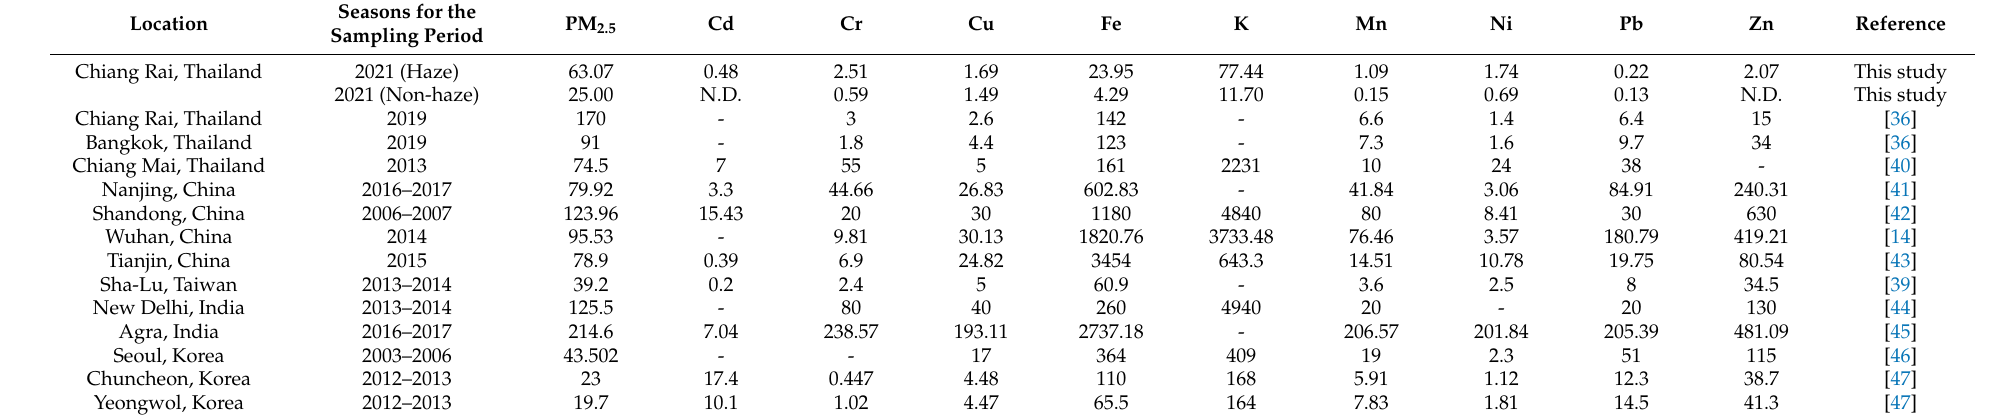
Table 2. Comparison of concentration of PM 2.5 ( µ g/m 3 ) and elemental composition (ng/m 3